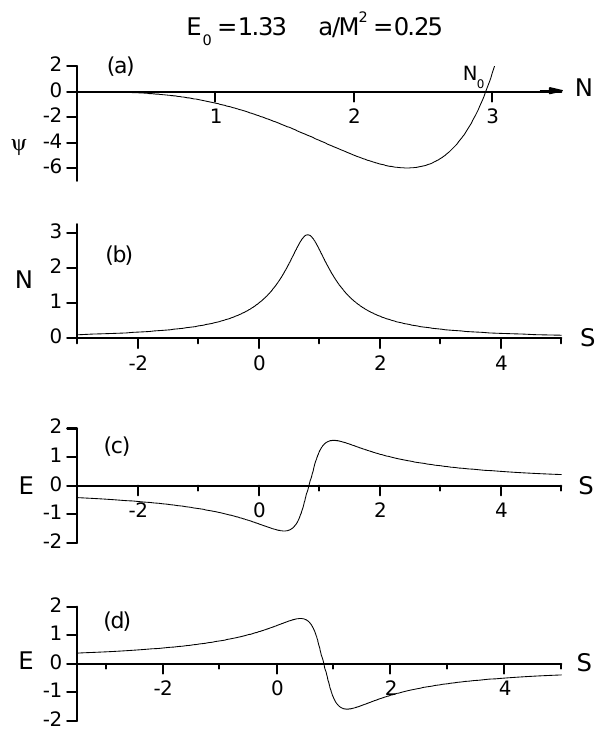
Fig. 2. Profile of “Sagdeev potential”, associated density soliton and EFS structures. (a) The “Sagdeev potential” 9(N) for the con- ditions (17–19) is plotted as a function of N . (b) Density soliton corresponding to 9(N) with a/M 2 =0.25 and | E 0 | =1.33. (c) Bipo- lar electric field structure corresponding to the density soliton when E 0 < 0. (d) Bipolar electric field structure corresponding to the den- sity soliton when E 0 > 0. We chose the magnetic field direction as the z -direction (also S direction) in our